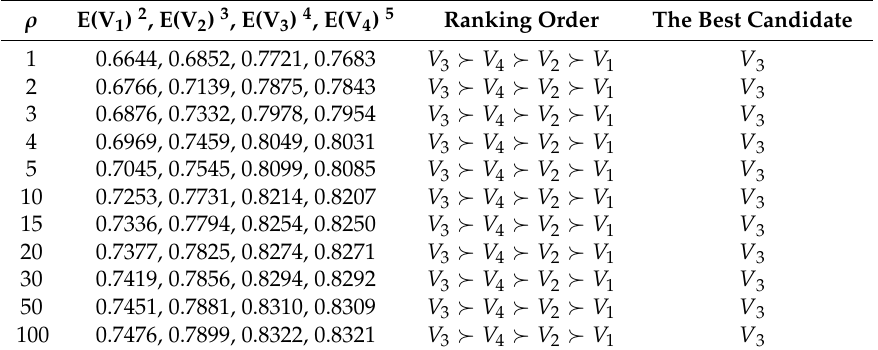
Table 1. Ranking orders of the LCVDWAA 1 operator, ρ ∈ [1–5,10,15,20,30,50,100].